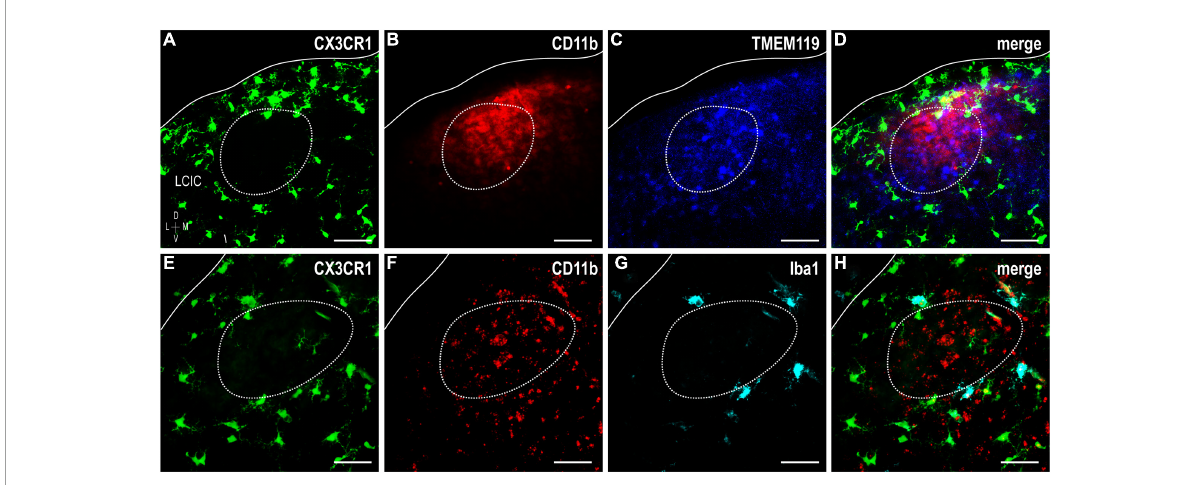
FIGURE9 Fractalkine receptor (CX3CR1)-GFP (green), integrin α M (CD11b) (red), and transmembrane protein (TMEM119) (blue) or Iba1 (cyan) expression at P8. Significant lack of co-localization of established MGC markers supports considerable lateral cortex of the inferior colliculus (LCIC) microglial diversity during its early critical period. CX3CR1-positive microglial cells (MGCs) occupy the matrix and surround modules ( dashed contours, for more see Brett et al., 2022) while CD11b and TMEM119 labeling exhibits a complementary modular bias (A–D) . Like CX3CR1, Iba1-positive microglia ring LCIC modules at P8, and are distinct from CD11b staining (E–H) . While all Iba1-positive cells also express CX3CR1, not all fractalkine receptor expressing cells are positive Iba1. Scale bars = 50 µ m.